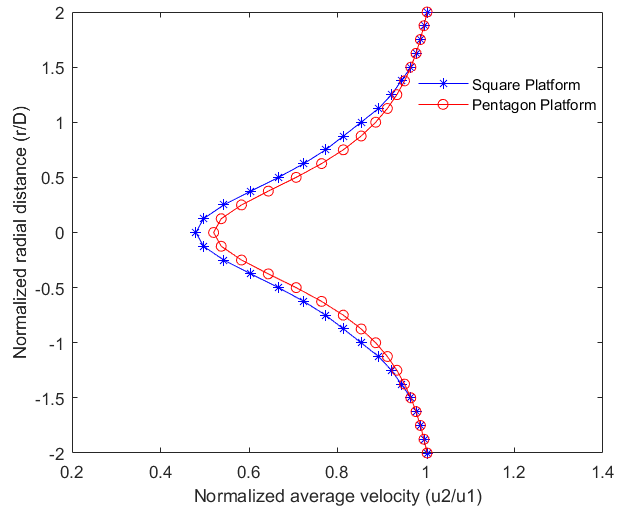
Figure 6. Velocity profile of the downstream turbine.